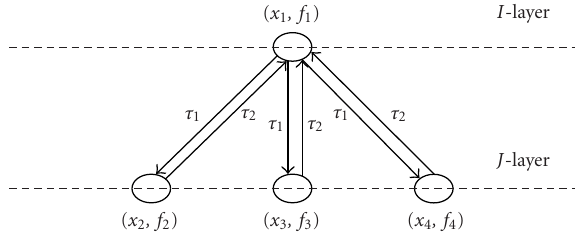
Figure 1.1. Graph of the architecture of the model